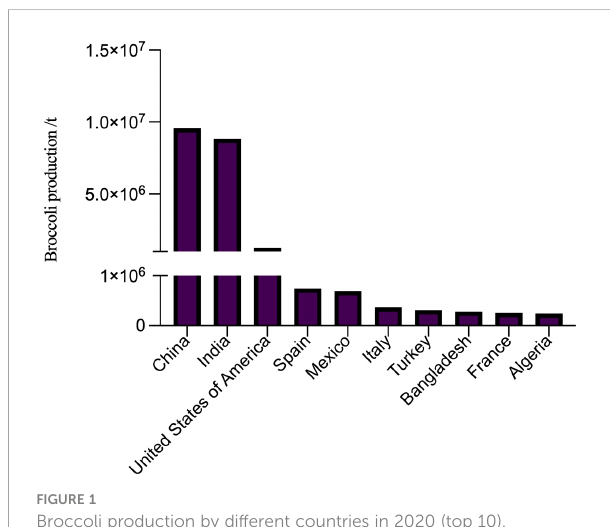
FIGURE 1 Broccoli production by different countries in 2020 (top